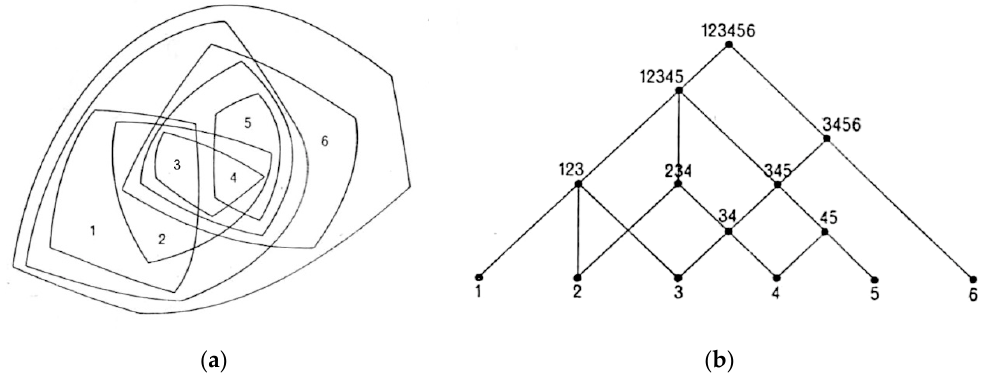
Figure 2. Subsequently in “A City Is Not a Tree” Alexander illustrated how a “semilattice”, or what we would now refer to as a complex network [23], has interconnecting or overlapping sets. Again, this is shown as a set diagram in ( a ) and a network diagram in ( b ). While this may seem messier, he said, it is actually a “thicker, tougher, more subtle and more complex” kind of structure, with greater internal connectivity. This structure is actually more closely related to many natural structures, including natural cities.